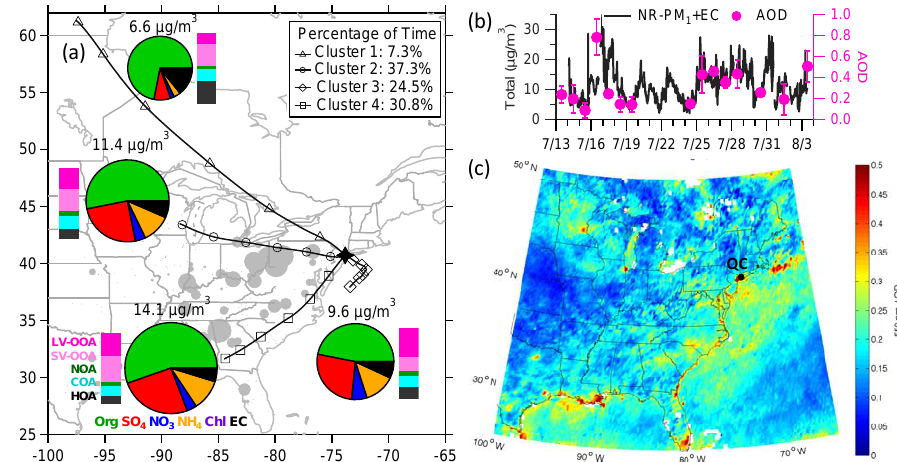
Fig. 15. (a) Average composition of PM 1 (pie charts) and OA (bar charts) for each cluster. The markers on the trajectories indicate 12h interval. The area of the pie chart is proportional to the total mass of PM 1 . The solid grey circles show the distribution of SO 2 emission sources from the EPA’s National Emission Inventory database (http://www.epa.gov/air/data/netemis.html). Bigger size indicates larger emissions. (b) Time series of total mass of PM 1 and AOD retrieved from Terra MODIS at 550nm and (c) distribution of average AOD for the entire